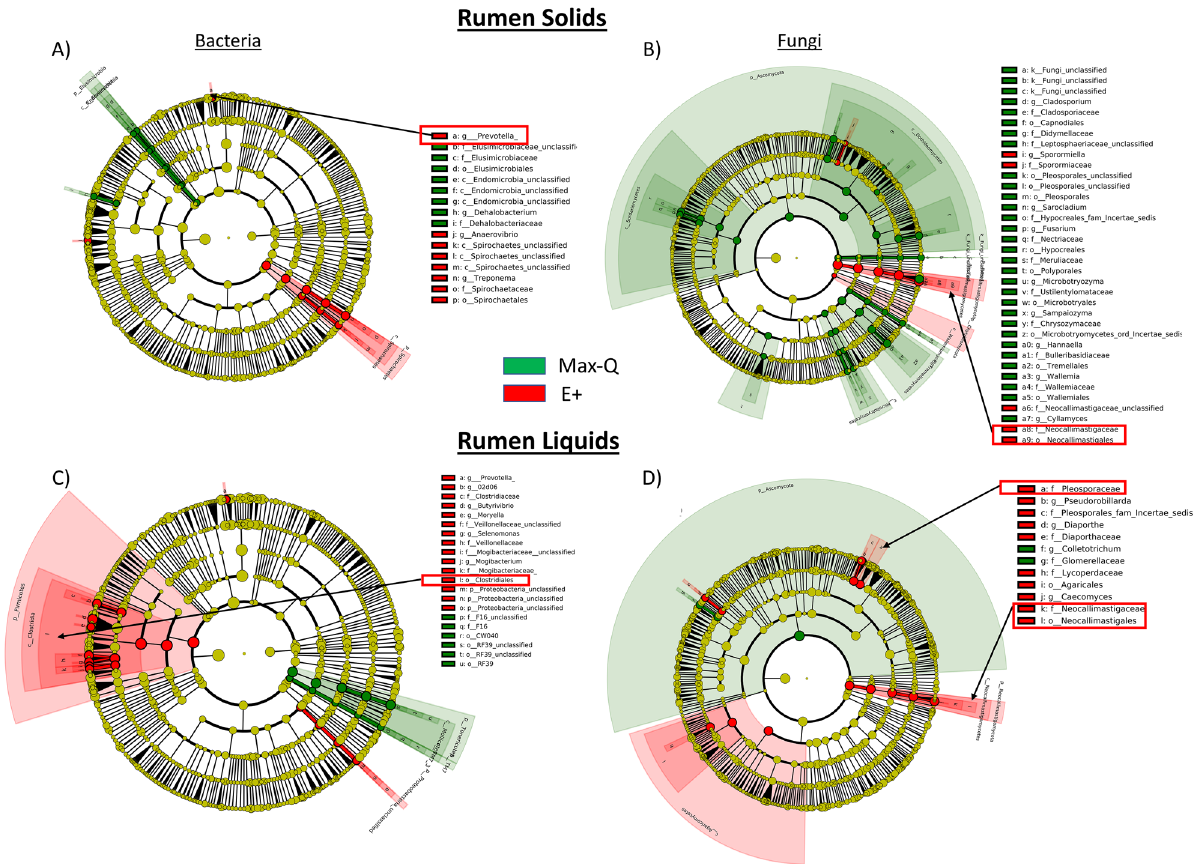
Figure 1. Linear discriminant analysis (LDA) effect size (LEfSe; Kruskal–Wallis [ P < 0.05]; Pairwise Wilcoxon [ P < 0.05]; logarithmic LDA score > 2.0) of the rumen solid ( A ) bacterial and ( B ) fungal and rumen liquid ( C ) bacterial and ( D ) fungal microbiota of Angus steers across a 28-day grazing trial after placement on either a non-toxic (Max-Q; n = 6) or toxic (E+; n = 6) endophyte-infected tall fescue. Green and red shading indicates greater abundance in Max-Q or E+ steers, respectively. Taxonomic rank labels are provided before microbe names: “p_; c_; o_; f_; g_” indicate phylum, class, order, family, and genus, respectively. Letters and numbers within the cladograms refer to respective bacterial or fungal names located in the keys to the right of each cladogram. Select taxa of interest are highlighted by boxes and arrows point to their position within a